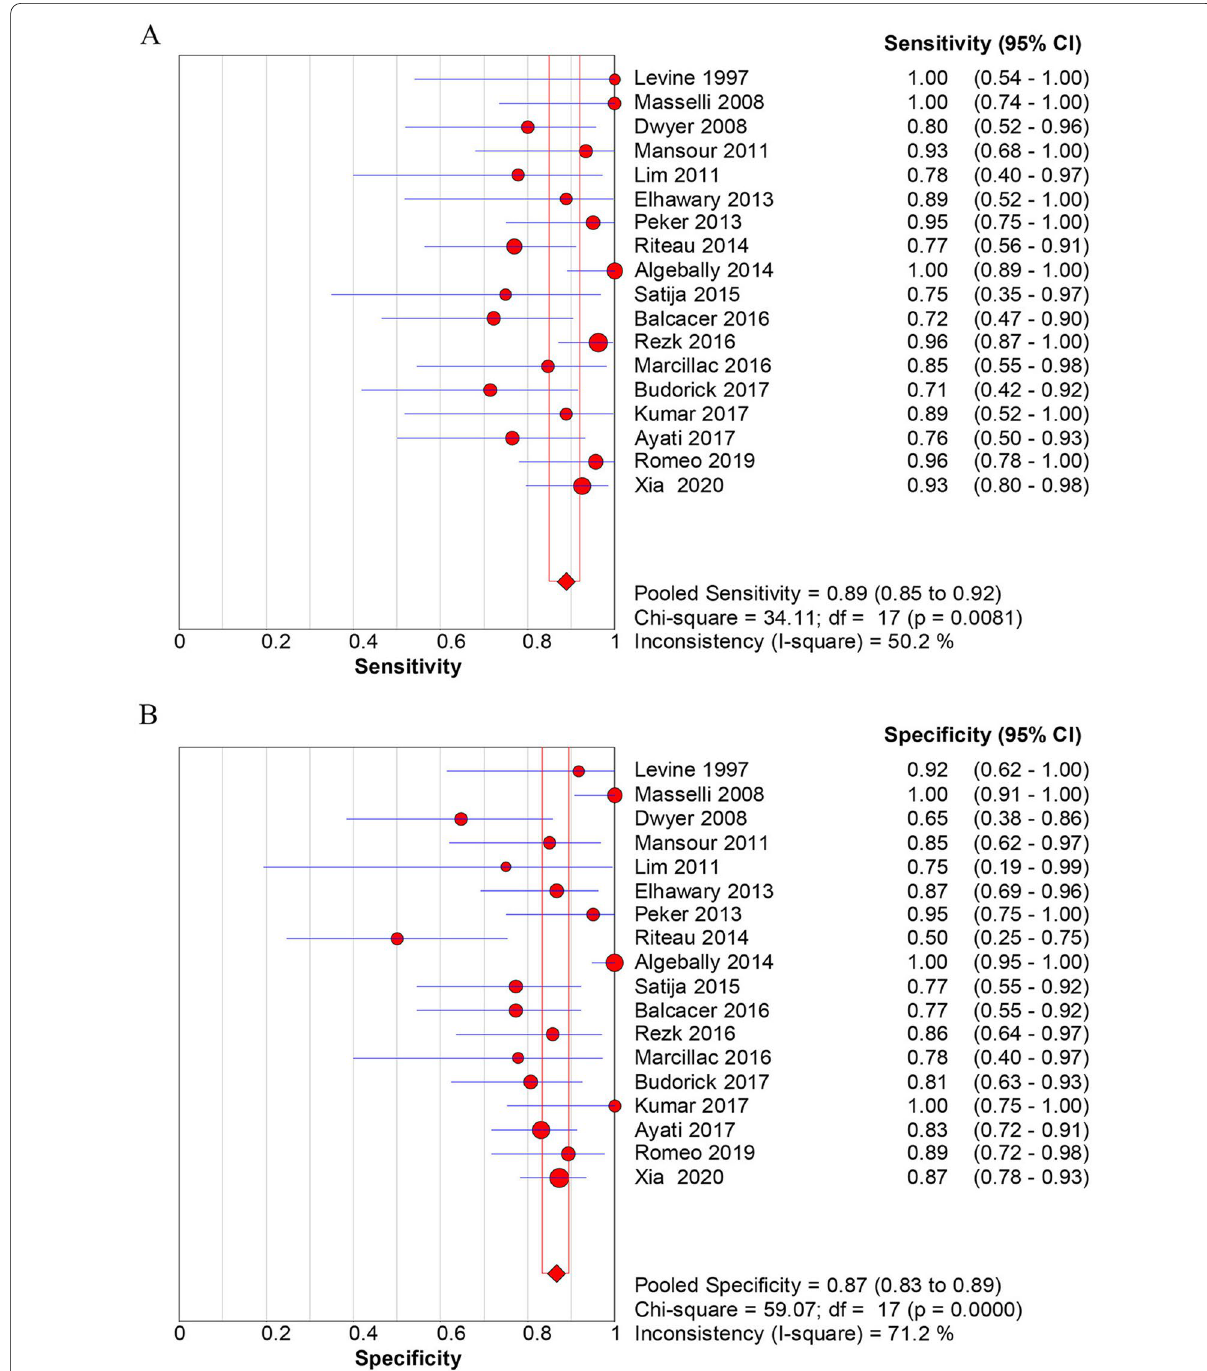
Fig. 5 Forest plots of the overall sensitivity ( A ) and specificity ( B ) of diagnosis of placenta accrete spectrum disorder (PAS) with magnetic resonance imaging (MRI). The first author’s name of each study is listed. CI, confidence